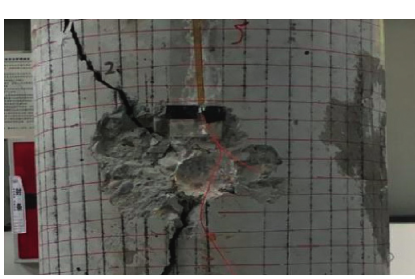
Figure 22: Damage condition of S